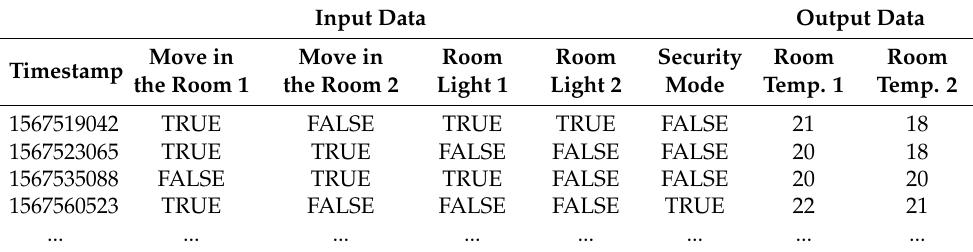
Table 2. A fragment of the data of the training sample to ensure an optimal